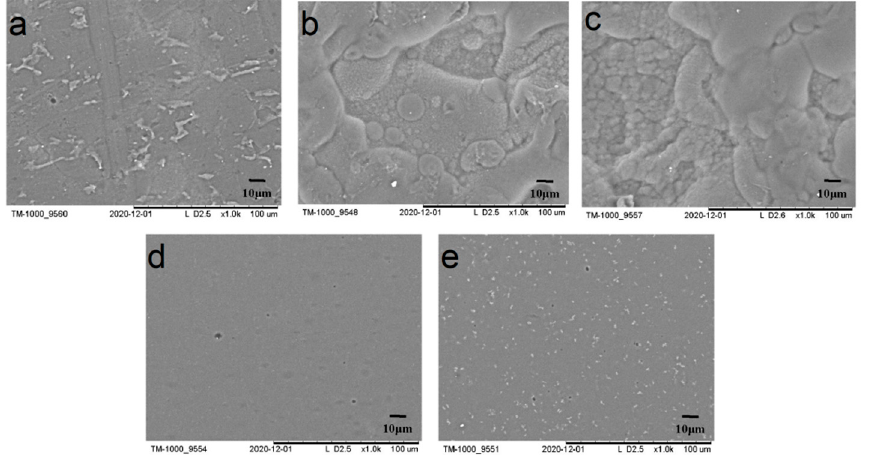
Figure 8. SEM images of SPI and fractioned films: ( a ) SPI, ( b ) upper protein, ( c ) lower protein, ( d ) 11S globulin, and ( e ) 7S